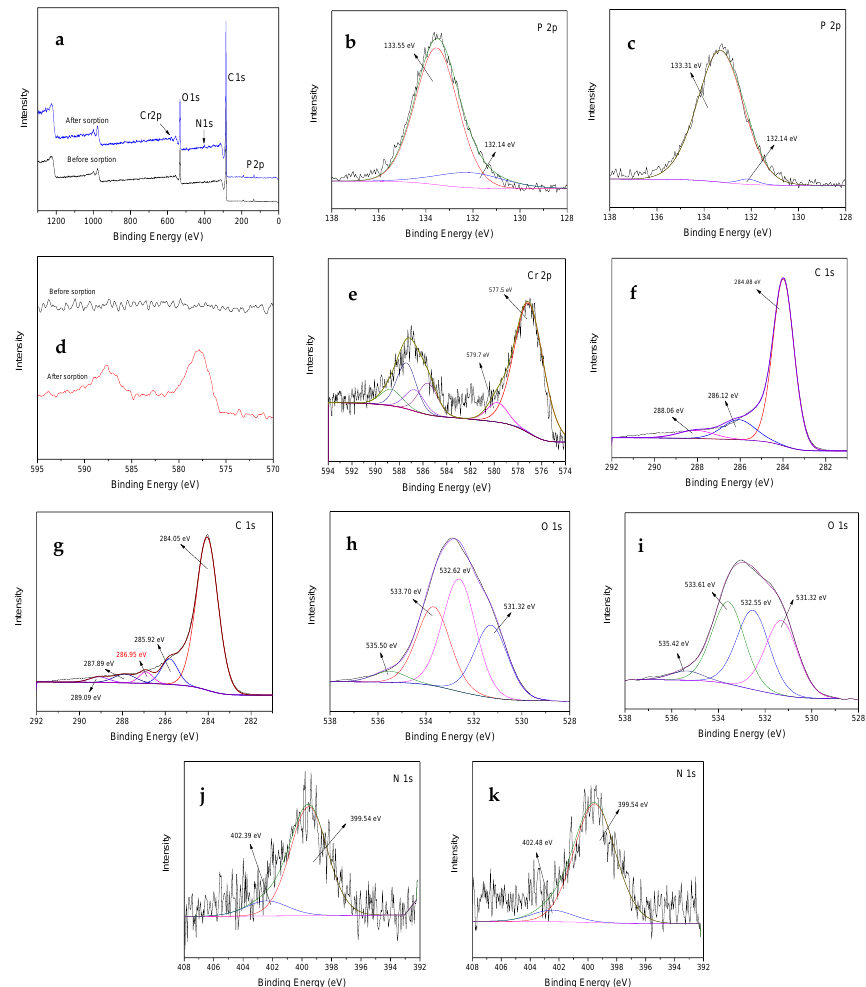
Figure 4. X-ray photoelectron spectroscopy of Typha angustifolia activated carbon: ( a ) whole; ( b ) and ( c ) high resolution P2p; ( d , e ) Cr2p; ( f , g ) C1s; ( h , i ) O1s; and ( j , k ) N1s spectra before and after adsorption,